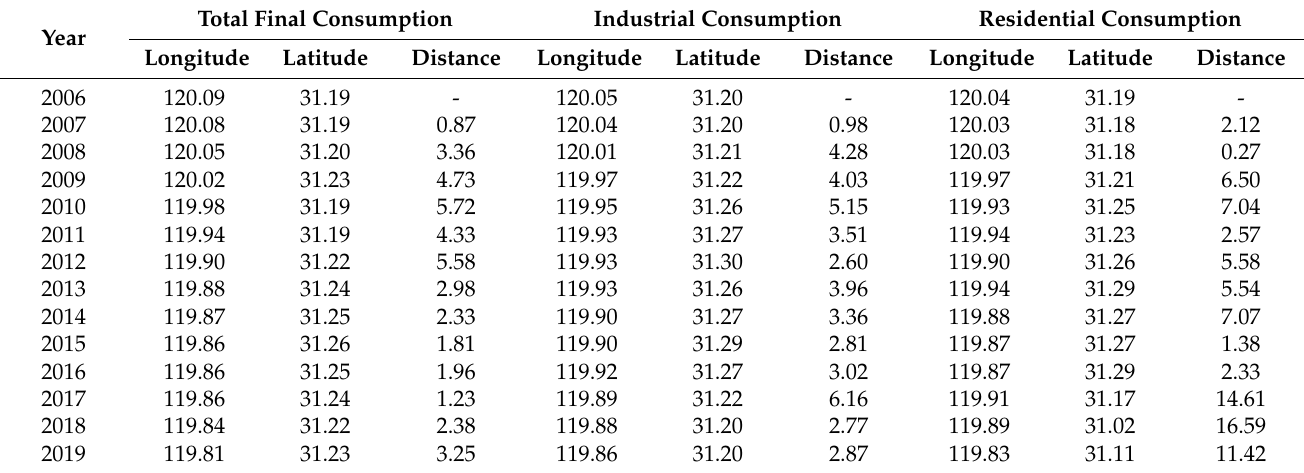
Table 2. Location and moving distance of the center of gravity for electricity consumption